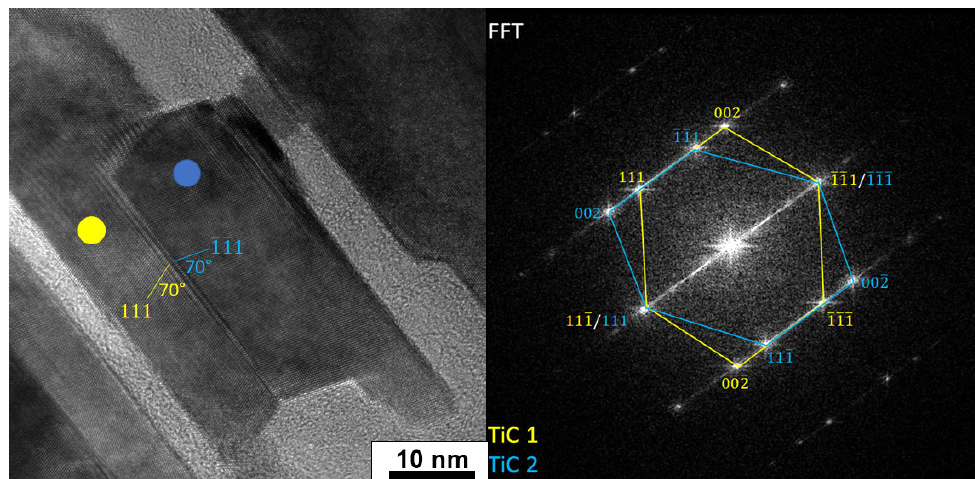
Figure 9. HRTEM image and fast Fourier transform (FFT) pattern of TiC twins.